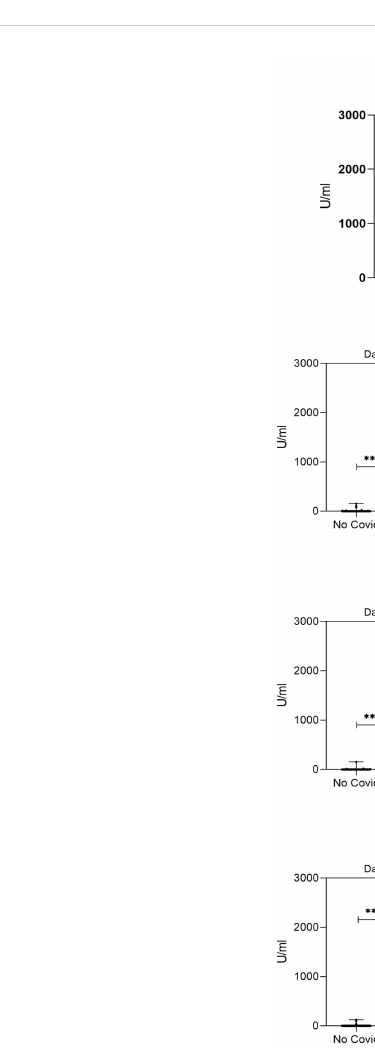
FIGURE 3 Levels of anti-S antibodies in the four groups of immunized subjects according to whether they experienced a COVID-19 infection, or not. T1: baseline values when administered the fi rst dose; T2: 21 days after the fi rst dose; T3: the time of the second dose; T4: 21 days after the second dose; T5: 180 days after the fi rst dose. Wiskers plots indicate median and interquartile range, with points representing individual data. Mann-Whitney U test; ***, p <.001; ****, p <.0001. Group A (two doses of the Sputnik vaccine separated by a 21-day interval): the Ab titers at T1, T3, T4, and T5 from volunteers with antecedents of COVID-19 infection were signi fi cantly different (****) from the ones of uninfected counterparts at all time points evaluations. Days 0, 21, 42, and 180 correspond to T1, T3, T4, and T5, respectively. Group B (two doses of the Sputnik vaccine separated by a 30-day interval: the Ab titers at T1, T2, T3, T4, and T5 from volunteers with antecedents of COVID-19 infection were signi fi cantly different (****) from the ones of uninfected counterparts at all time points evaluations. Days 0, 21, 30, 51, and 180 correspond to T1, T2, T3, T4, and T5, respectively. Group C (two doses of the Sputnik vaccine separated by a 70-day interval): the Ab titers at T1, T2, T3, T4, and T5 from volunteers with antecedents of COVID-19 infection were signi fi cantly different (****) from the ones of uninfected counterparts at all time points evaluations. Days 0, 21, 70, 91, and 180 correspond to T1, T2, T3, T4, and T5, respectively. Group D ( fi rst dose of the Sputnik vaccine, followed by a second dose of Moderna vaccine separated by a 107-day interval). The Ab titers at T1, T2, T3, T4, and T5, from volunteers with antecedents of COVID-19 infection were signi fi cantly different from the ones of uninfected counterparts at all time point evaluations (T1, T2, T3, and T4 p<0.0001; T5 p<0.001). Days 0, 21, 107, 128, and 180 correspond to T1, T2, T3, T4, and T5,